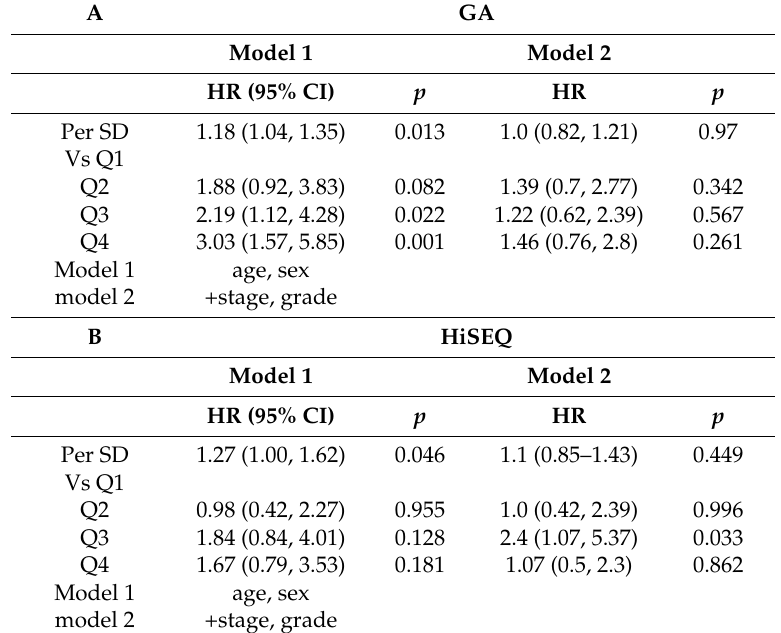
Table 3. Cox multivariate analyses for the GA (A) and HiSeq (B) datasets. miR-155 levels were used together with age and gender (Model 1) and age, gender, tumour stage and histological grade (Model